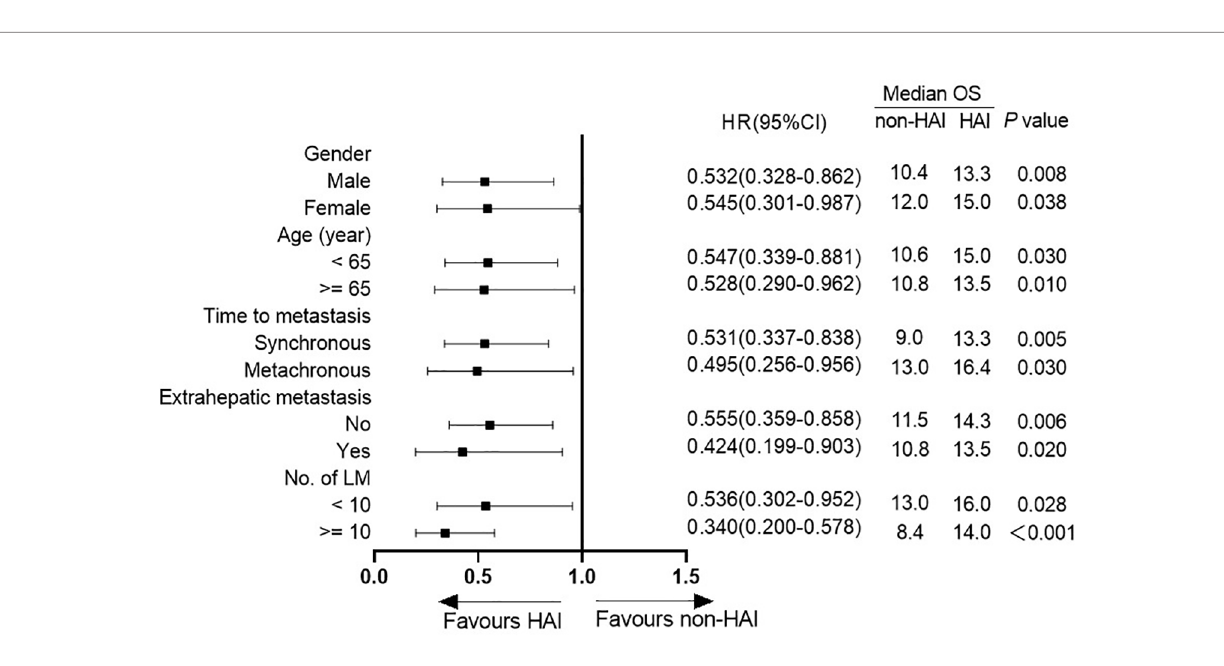
FIGURE 3 | Forest plot of subgroup